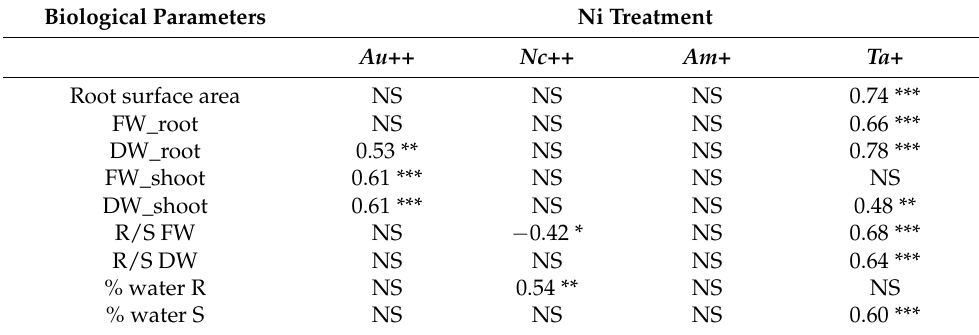
Table 1. Spearman’s rank correlations coefficients between Ni concentration and biological parame- ters of test species: root surface area, fresh and dry weight (FW, DW) of root and shoot, root/shoot ratio (R/S) and water content (%). n = 20 each treatment. Au: A. utriculata, Nc: N. caerulescens, Am: A. montanum, Ta: T. arvense. ++ hyperaccumulator species, + non-hyperaccumulator species. * p < 0.05, ** p < 0.01, *** p < 0.001, NS: not significant.